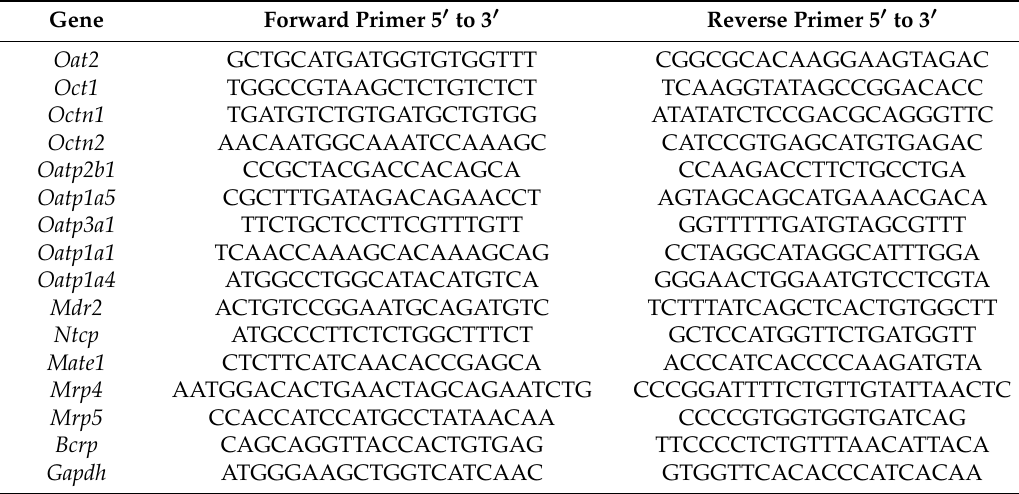
Table 6. Primer sequences used for real-time quantitative